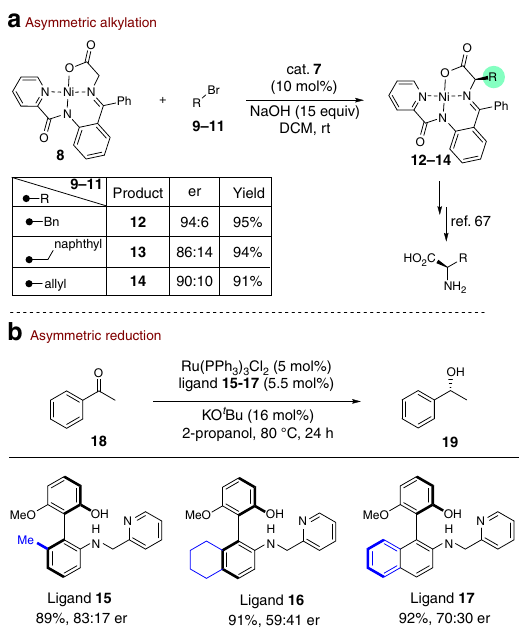
Fig. 6 Synthetic applications. a Use of 7 as a chiral catalyst. b Utility of 15 –